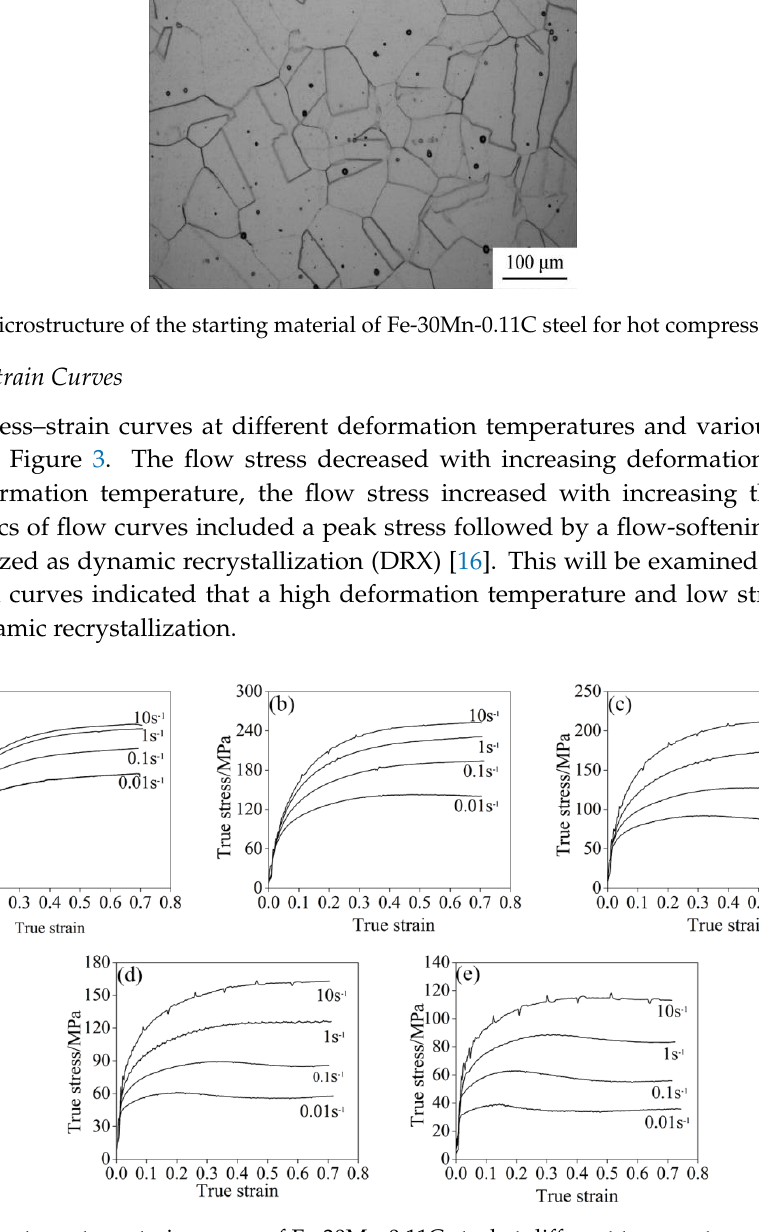
Figure 3. True stress–true strain curves of Fe-30Mn-0.11C steel at different temperatures and strain rates: ( a ) 800 °C; ( b ) 900 °C; ( c ) 1000 °C; ( d ) 1100 °C and ( e ) 1200 °C.